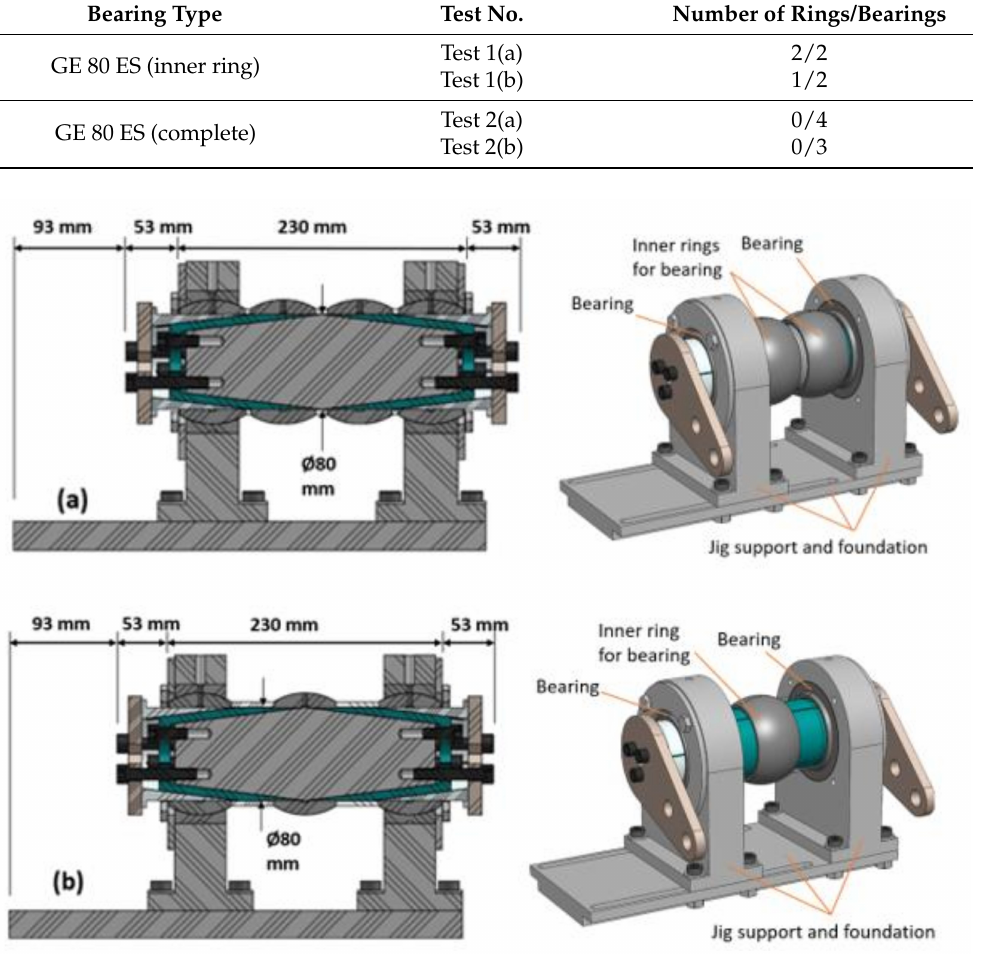
Figure 4. Test setup for Test 1: ( a ) Test 1a—cross sectional view (left) and isometric view with part names (right); ( b ) Test 1b—cross sectional view (left) and isometric view with part names